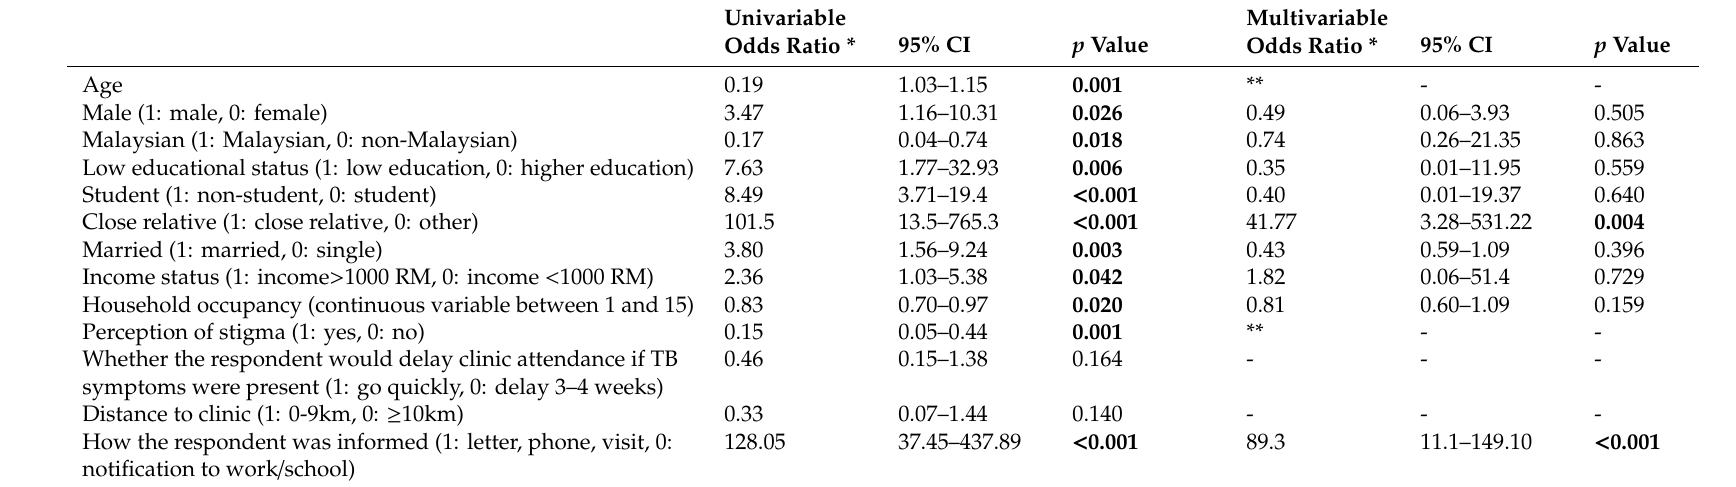
Table 4. Factors associated with clinic attendance for contact